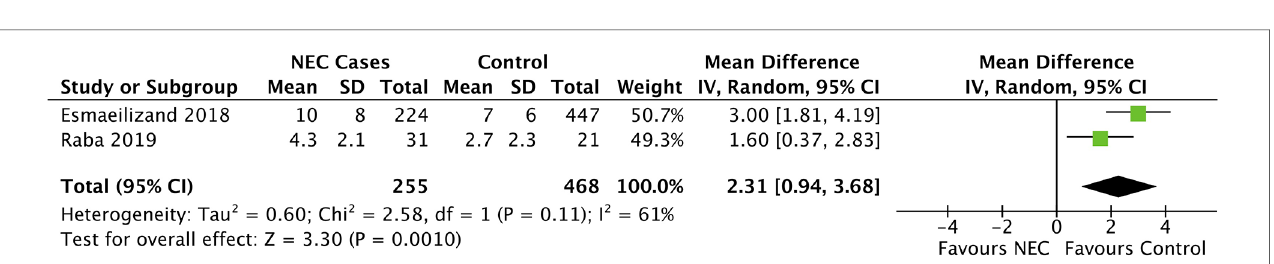
FIGURE 4 Forest plot of case – control studies comparing EAB and PEAB. For NEC cases, antibiotic treatment in days before NEC onset was compared with controls. Mean differences were calculated using RevMan. EAB, empirical antibiotics use; PEAB, Prolonged EAB; NEC, necrotizing enterocolitis; CI, con fi dence interval.